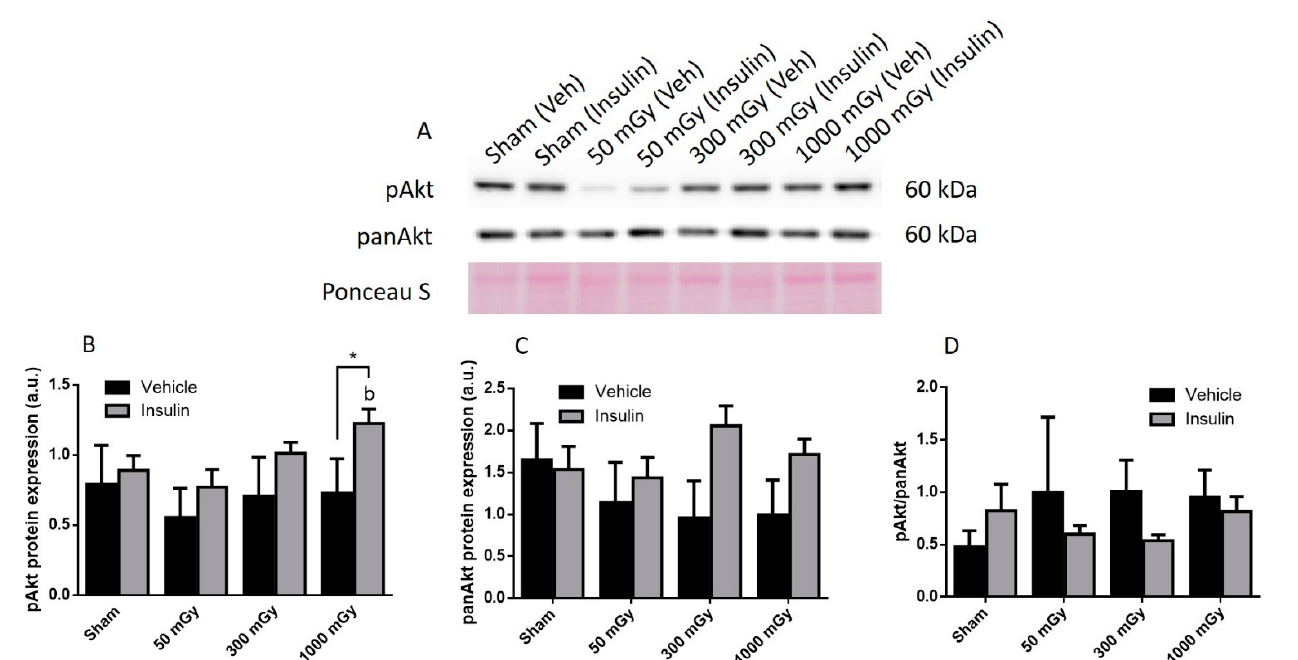
Figure 4. Representative western blot ( A ) and quantified band density (relative protein expression in arbitrary units) for phosphorylated Akt (pAkt) ( B ), Pan Akt (panAkt) ( C ), and the ratio of phosphorylated protein to total protein ( D ) in female offspring hearts. Results were normalized to loading controls (samples repeated on each gel) to account for differences between gels, and Ponceau S staining was used as a marker of equal protein loading. Data are presented as a mean ± SEM. *, denotes significantly different between vehicle and insulin injections, b—is significantly different from 50 mGy group, and p ≤ 0.05. n = 11–19 per group.